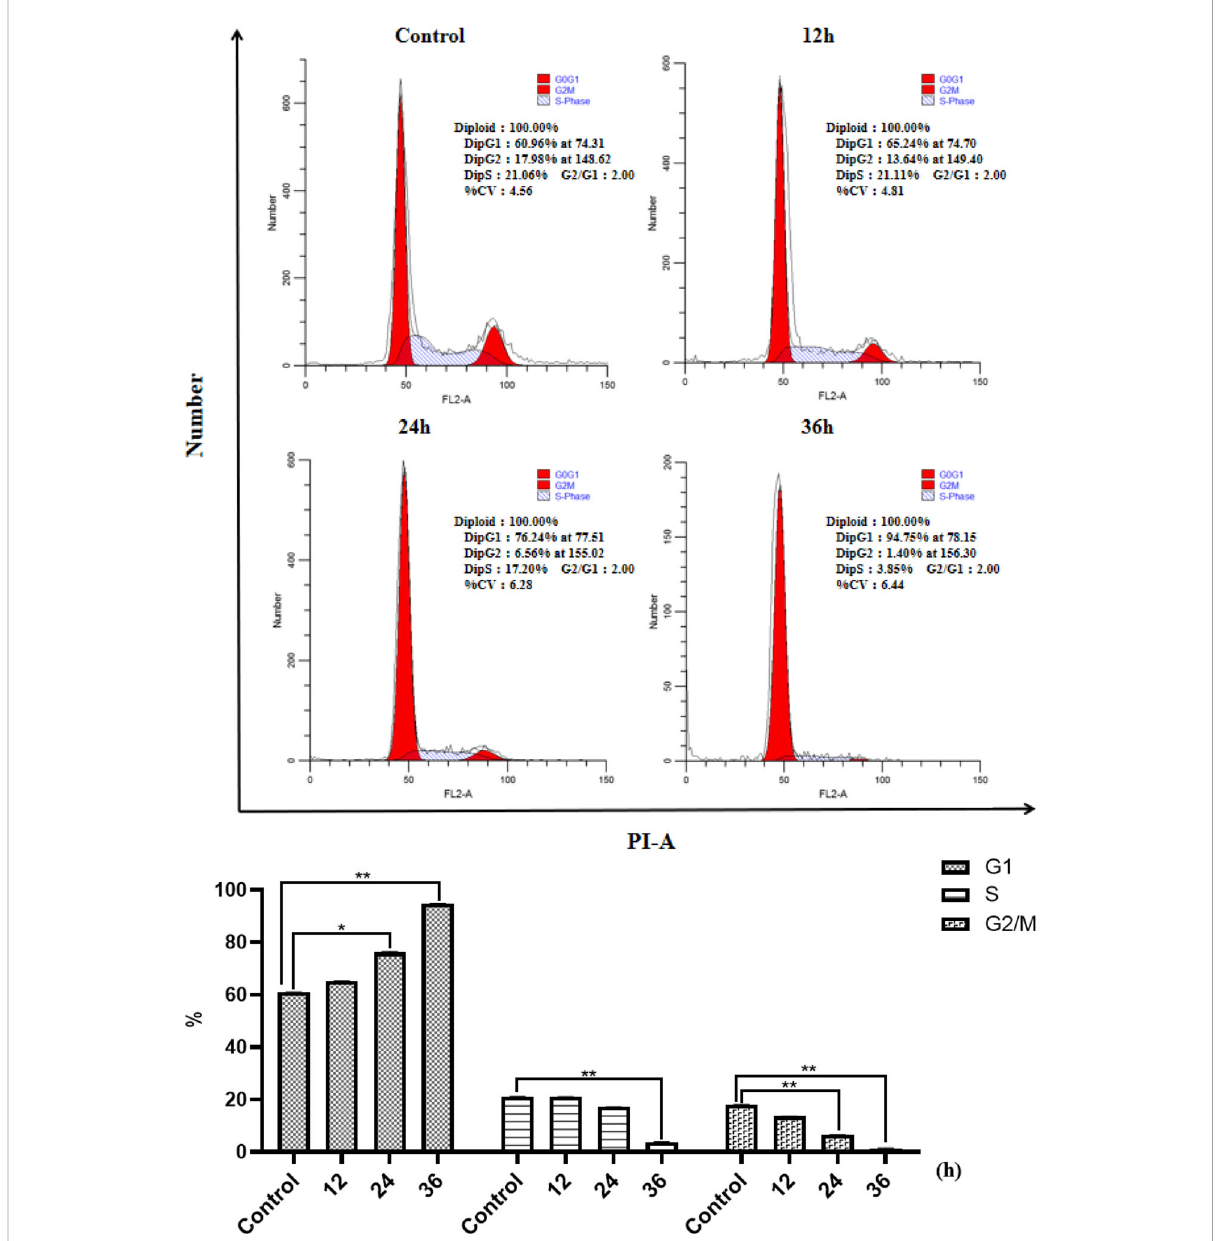
FIGURE 4 Effect of HP-1 on the cell cycle of NCI-H460 cells in time dependence. Data shown are the mean ± SD of three independent experiments (* p <0.05, ** p <0.01, compared to negative